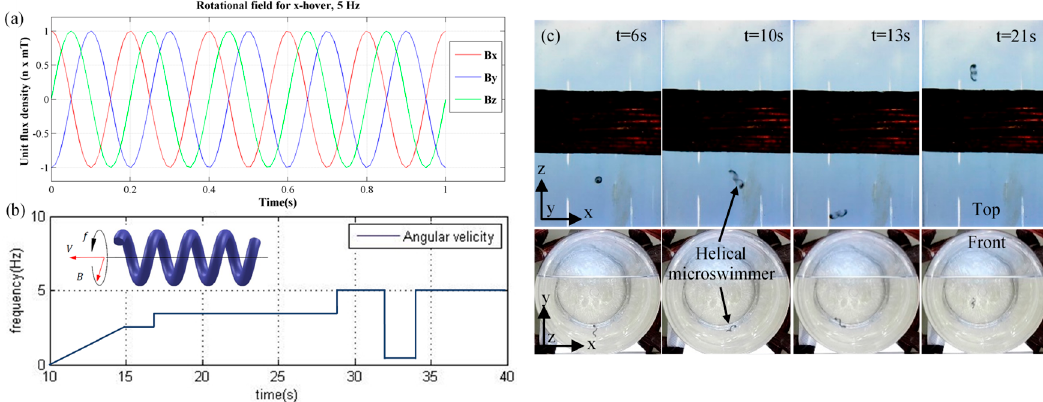
Figure 8. Helical propulsion in the large workspace ( r 6 × 15-cm-eylinder). ( a ) a sample of 5 Hz rotation frequency for a hover swimming toward the x-direction. ( b ) rotation frequency is variant from 0 to 5 Hz by the velocity control algorithm to drive the swimmer. ( c ) swimming of the helical robot against time over the whole journey, displayed by the top and front view.